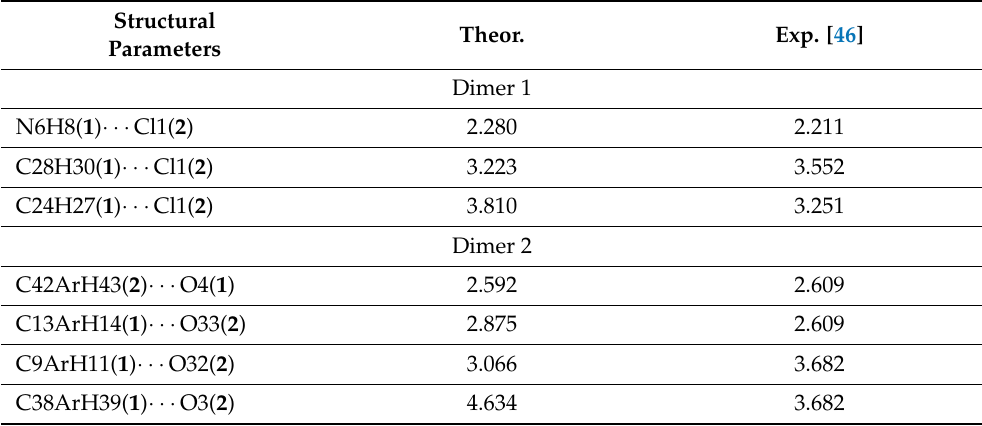
Table 2. Selected intermolecular distances (Å) for the dimer 1 and dimer 2 of methylone hydrochloride calculated at the B3LYP/6-31G(d,p) theory